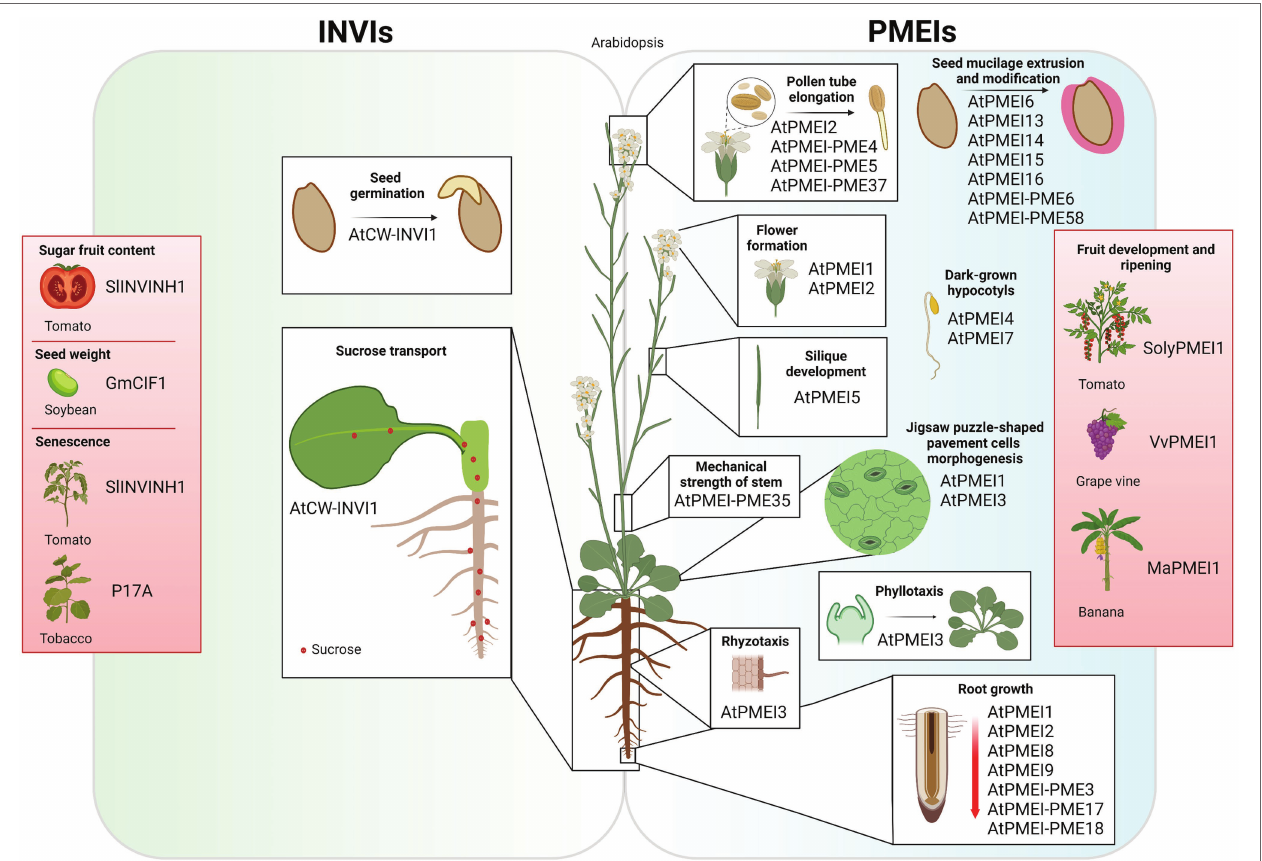
FIGURE 5 | Overview of INVIs and PMEIs functions in plant growth and development. INVIs control seed germination, sugar transport in roots; senescence and sugar fruit content. PMEIs play multiple roles in several physiological processes, such as pollen tube elongation, seed mucilage extrusion, and modification, flowering transition, silique development, mechanical strength of stem, phyllotaxis, rhyzotaxis, pavement cells morphogenesis, hypocotyl growth in the dark, and root growth, and they are also involved in fruit development and